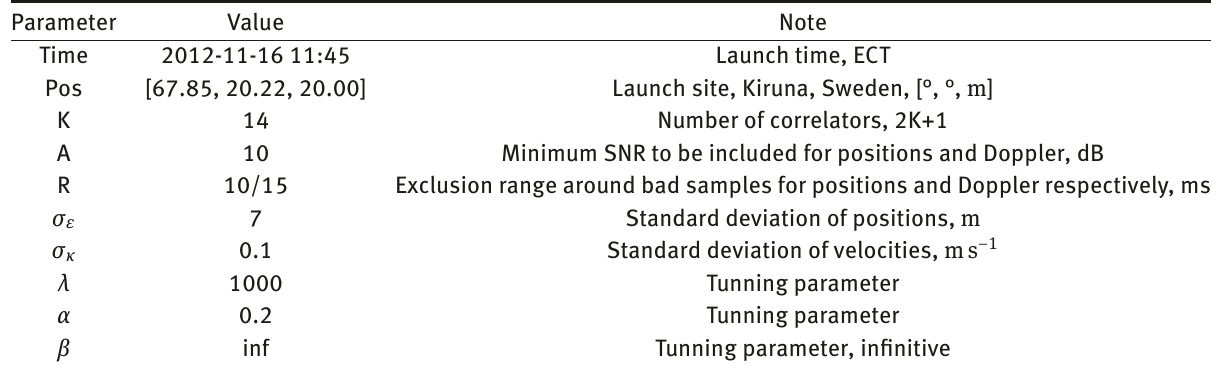
Table 1: Initial parameters